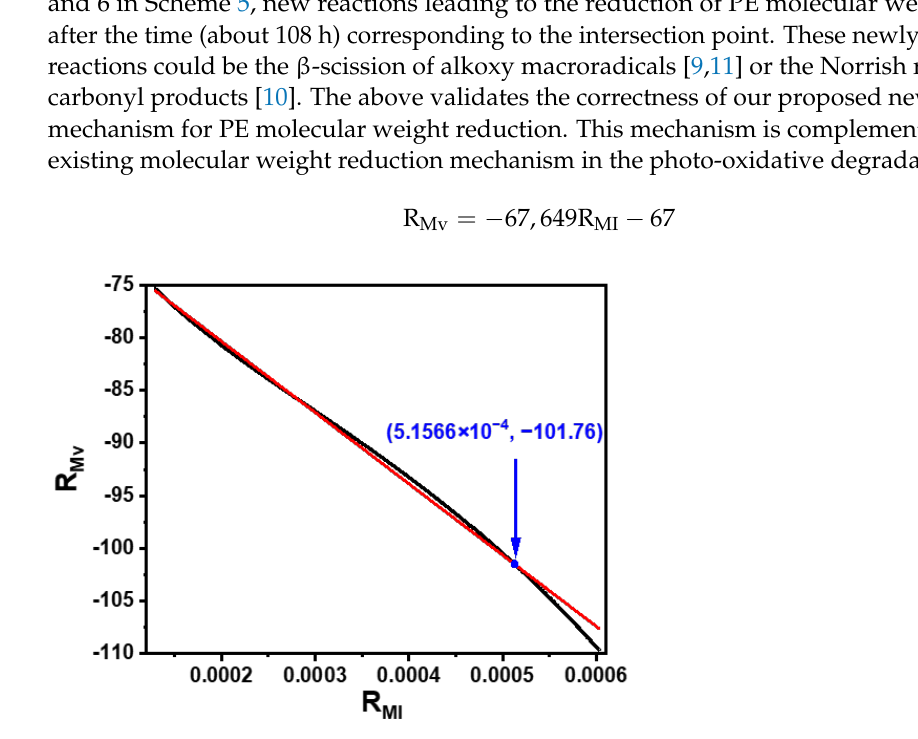
Figure 9. Relationship between R Mv and R MI of PE sample films in the photoreaction stage. Black: scatter. Red: fitting curve, adj. R-square = 0.9972.